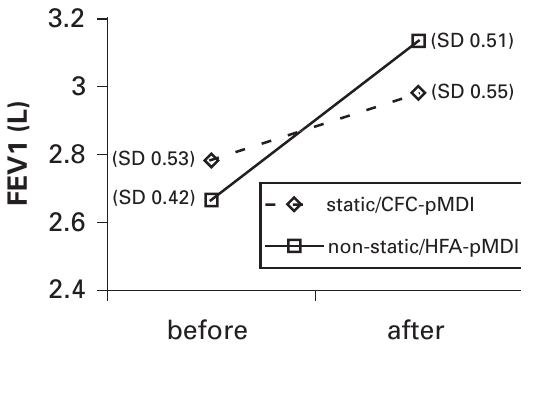
Flow-volume curves before and five minutes after inhala- tion of 200 µ g salbutamol from a CFC-pMDI through a new, static spacer (Nebuhaler ® ) and from an HFA-pMDI through a detergent-coated, non-static spacer (Nebuhaler ®